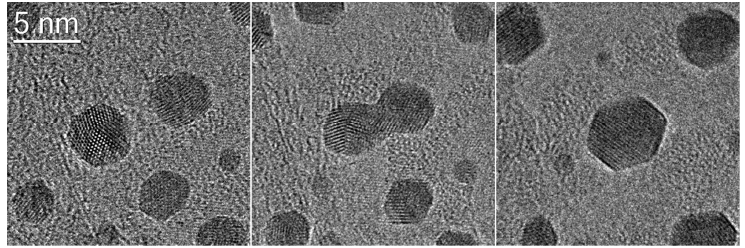
Figure 20. Coalescence of Au nanoparticles supported on graphene via migration of nanoparticles. The snapshots correspond to time t = 0 s, 56 s and 94 s. Conditions of acquisition: T = 373 K, P H = 200 Pa, 300 kV. Reprinted with permission from [245]. Copyright 2014, American 2 Chemical